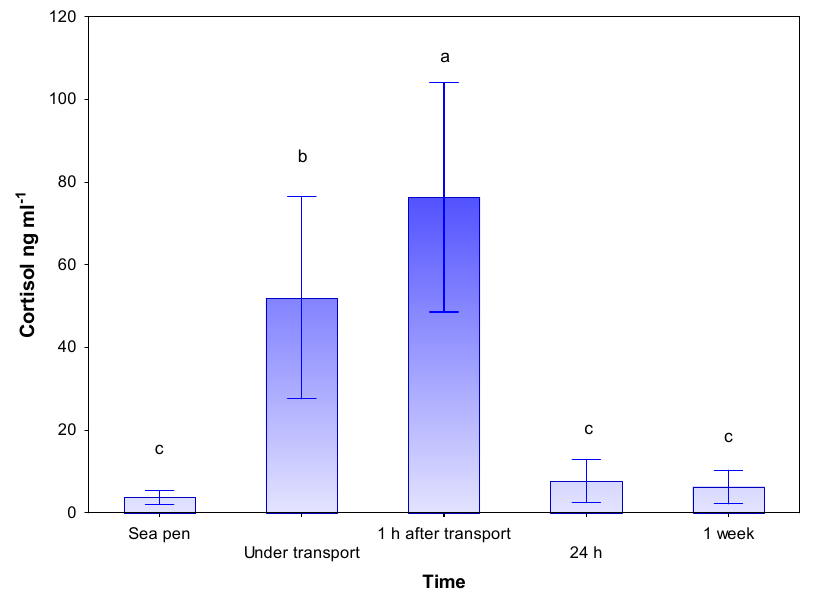
Figure 1. Changes in blood plasma cortisol for lumpfish before and under transport, and 1 h, 24 h and one week after transport. Values are given as mean (SD). N = 20–30 for all groups. Different letters denote significant difference (Student–Newman–Keuls (SNK) test, p < 0.05) between treatments.